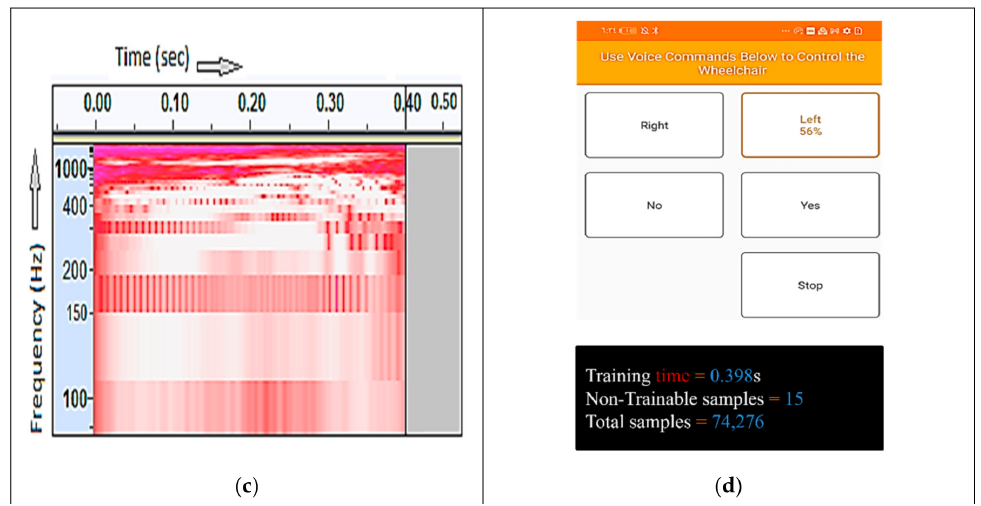
Figure 7. Recognition of the “Left” voice command. ( a ) Audio shape; training time = 0.398 s;